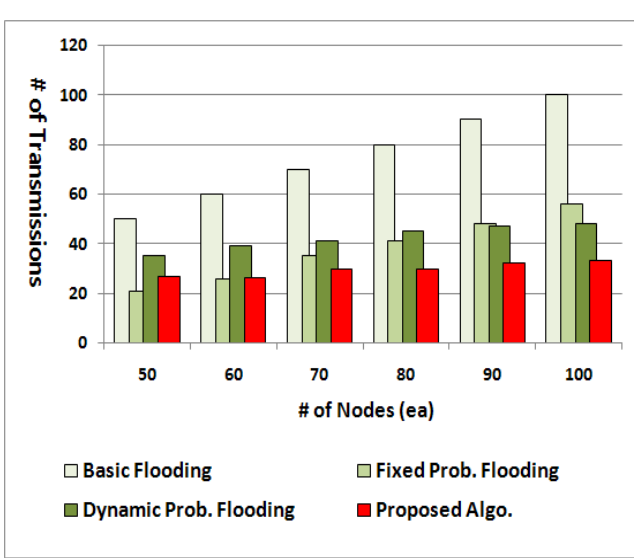
Figure 12. Number of duplicate